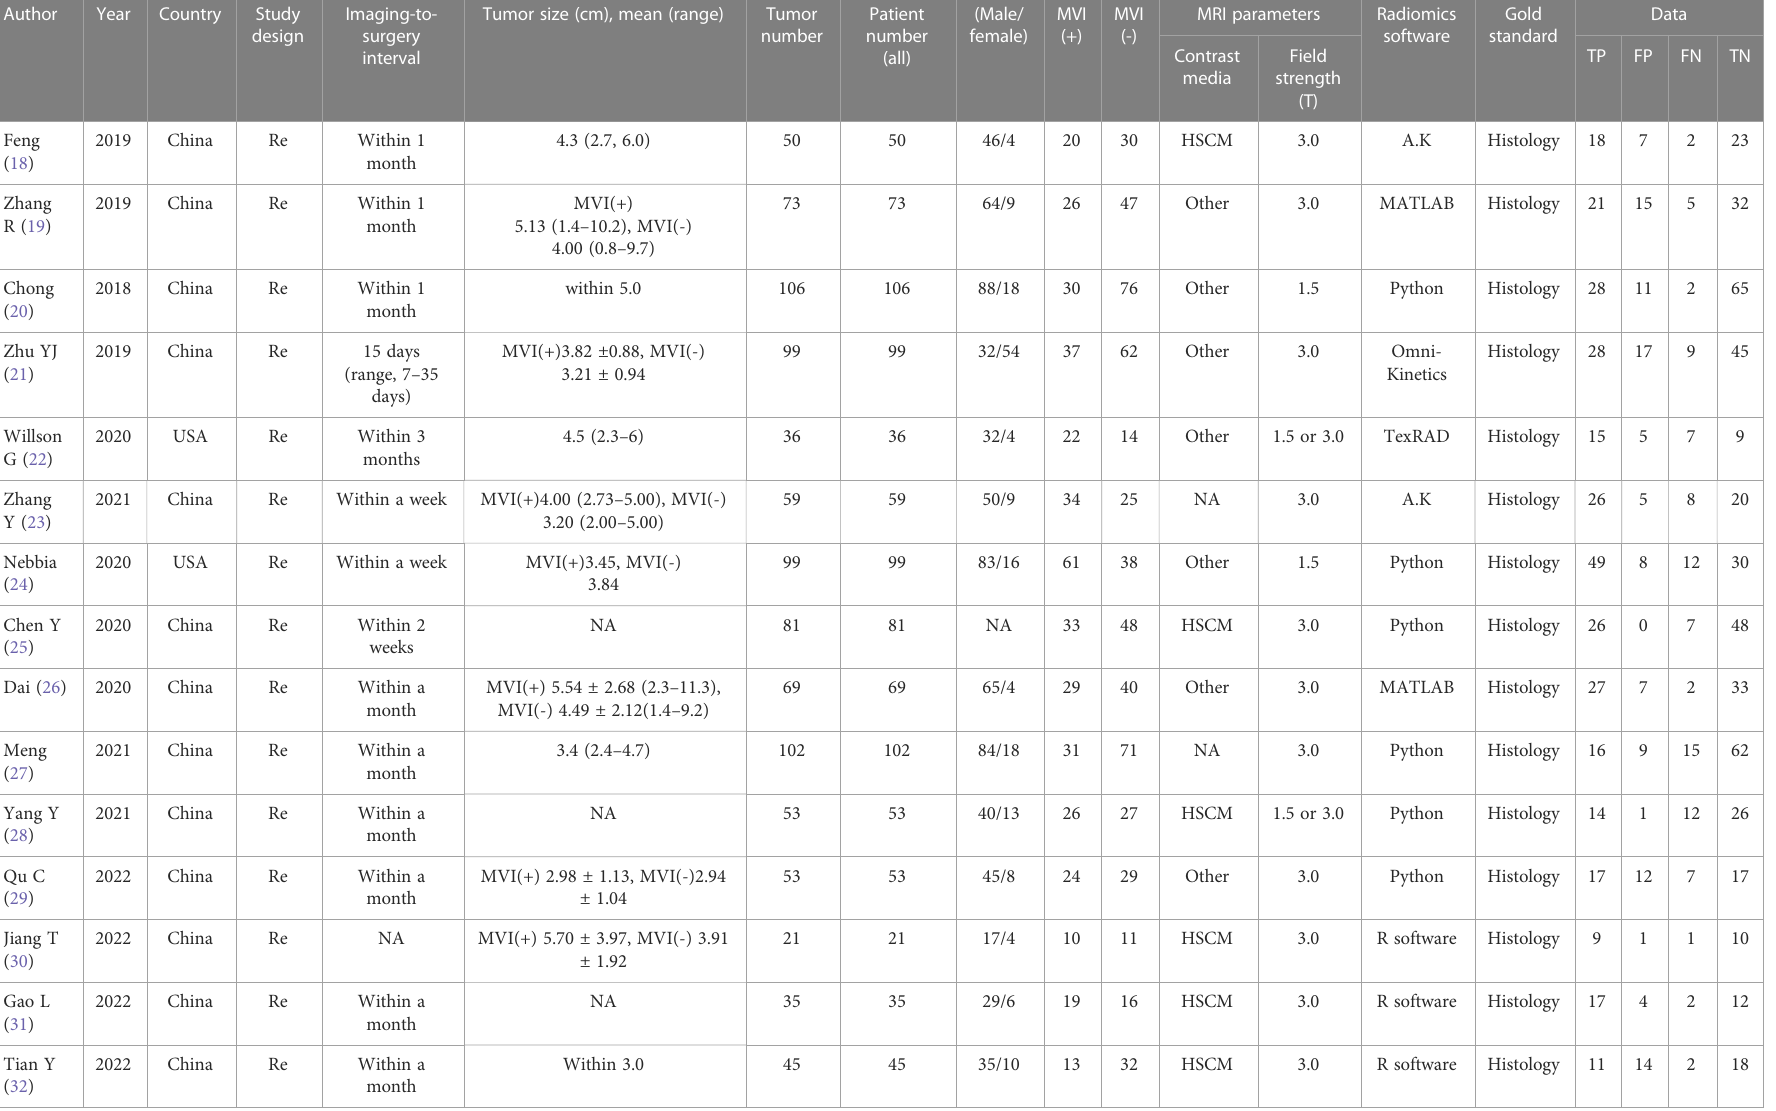
Characteristics of included studies in the